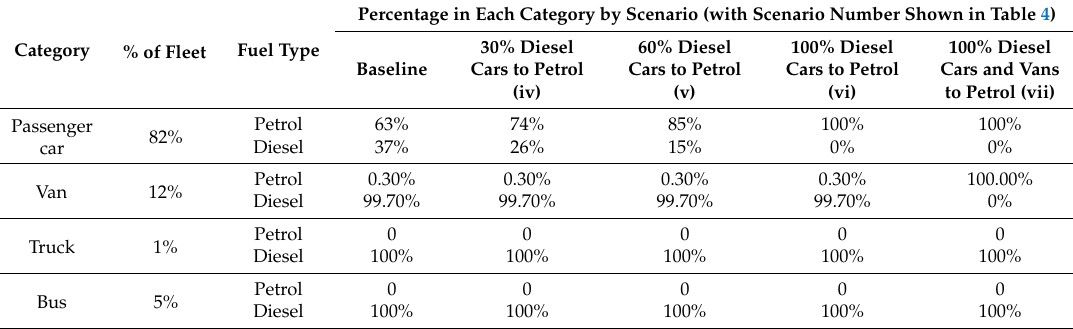
Table 2. Fleet data for each category and fuel type for different fleet change scenarios.